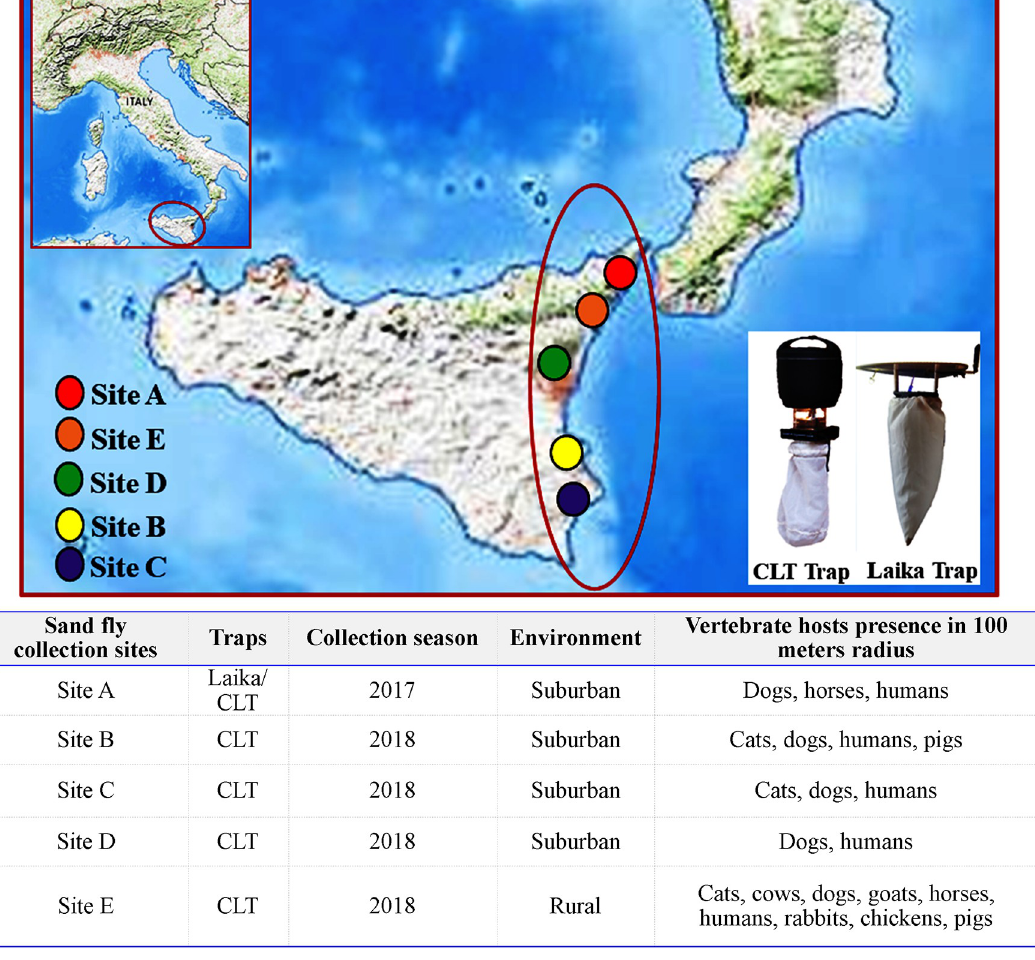
Fig 1. Geographical characteristics of sand fly sampling sites and presence of vertebrate